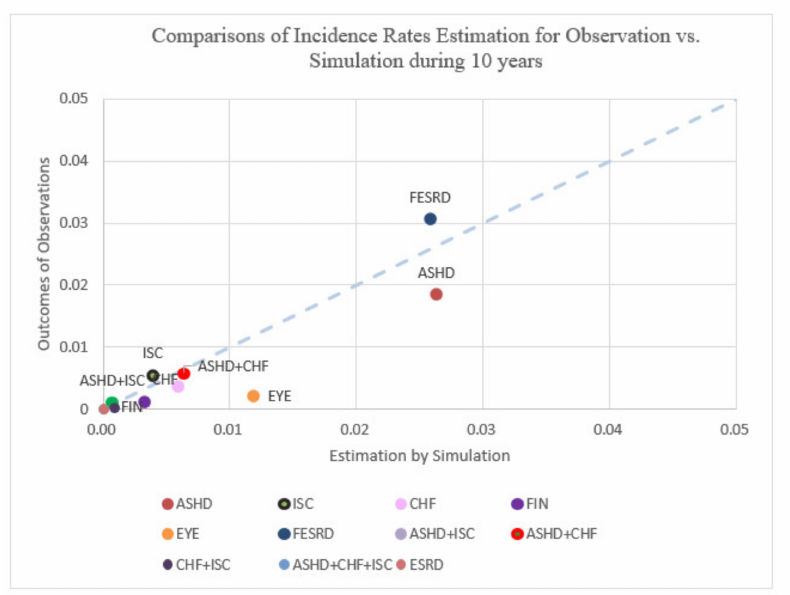
Figure 6. Comparisons of incidence rates estimation for observation vs. simulation over the course of 10